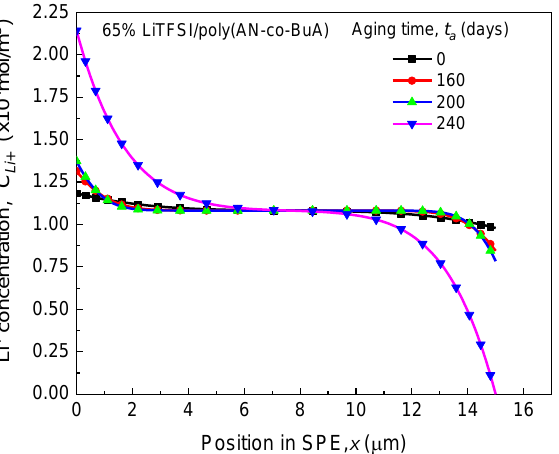
Figure 4. Effects of aging time on Li + concentration distribution in SPE at the cutoff time. (1) As can be seen from the ASSB structure (see Figure 1) above, the left-side (anode) and right-side (cathode) are corresponding to the outflow and insertion of Li + , respec- tively, under the discharging, which means that ions move from left to right in the SPE. It can be anticipated that the higher the ion mobility, the smaller the difference in concen- tration will be observed between the two sides. Conversely, a tremendous difference in ion concentration between the two sides means worse ion mobility. Therefore, Figure 4 indicates that the transport performance of ions continues to deteriorate with aging. When the aging time is relatively short ( 200 days), though the mobile rate of the cation has de- creased, it still matches with the lithiation requirement of the cathode at the right-side of the electrolyte, and thus, the discharge capacity has not changed significantly, as shown in Figure 3. However, after 240 days of aging, when the diffusion coefficient of lithium- ion in SPE declines to a threshold that the rate of Li + passing through the SPE can no longer meet the consumption of lithium embedding in the cathode, the Li + concentration on the right-side of SPE would rapidly reduce to 0. This will interrupt the electrochemical reac- tion of the electrode, shorten the discharge time, and thereby decrease the discharge ca- pacity of the ASSB significantly. (2) During the time-aging of SPE, the structural relaxation induced by the lattice con- traction [31] and free volume diffusion in the solid electrolyte also cause the reduction of effective contact between the SPE and LiCoO 2 . The related influence can be obtained by extracting the variation of the aging-related parameters 𝜆 and 𝐴/𝐴 0 . These results are shown in Figure 5.